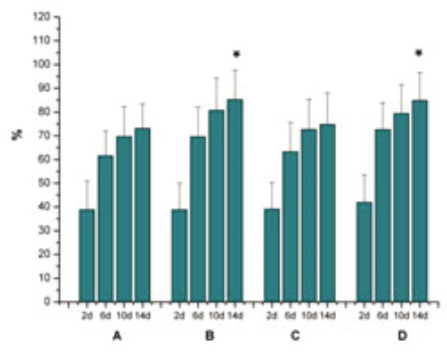
FIGURE 6 – Percent area occupied by mature collagen fibers in relation to total repair area in wounds experimentally induced in Wistar rats. Group A, control; group B treated with microcurrent (10 μA/2 min/day); group C treated with Jatropha curcas seed oil, and group D treated with Jatropha curcas seed oil and microcurrent (10 μA/2 min/day). Tissue samples were collected on day 2 (2d), 6 (6d), 10 (10d), and 14 (14d) after injury. Results are reported as the mean and standard deviation of each group and were compared by ANOVA and Tukey’s post-hoc test (p<0.05). The asterisk indicates significant differences between time